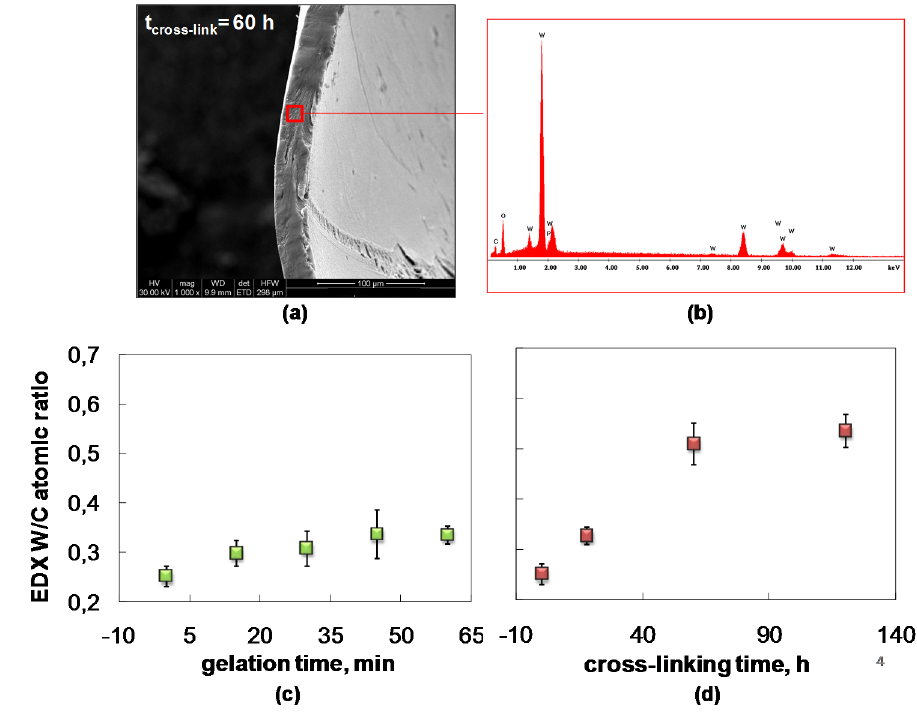
Figure 4. Composite Chit/PWA flat structures prepared according to theBIG method at 2% wt / v Chit. ( a ) Typical SEM cross-section; ( b ) typical EDX spectrum; EDX quantitative W/C atomic ratio versus ( c ) BIG gelation time and ( d ) post crosslinking